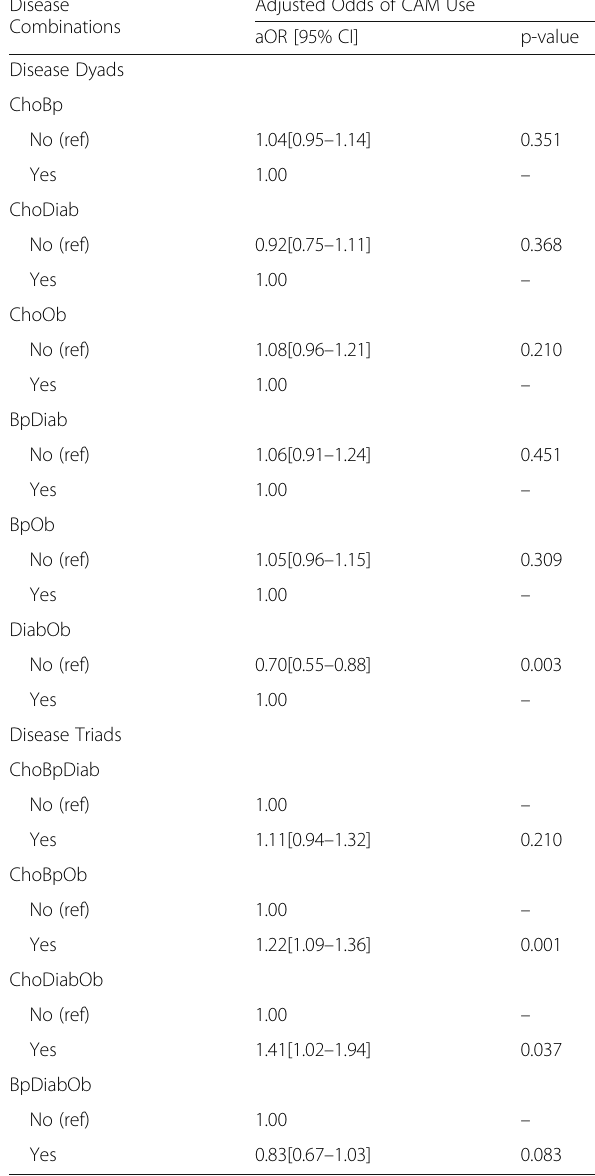
Adjusted Odds of CAM Use